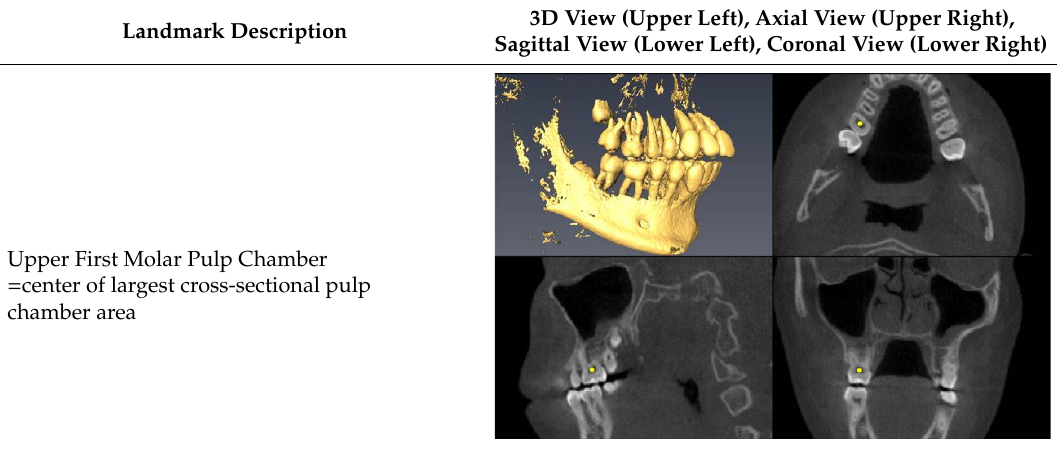
Table 2. Dental and skeletal landmarks used in the study .